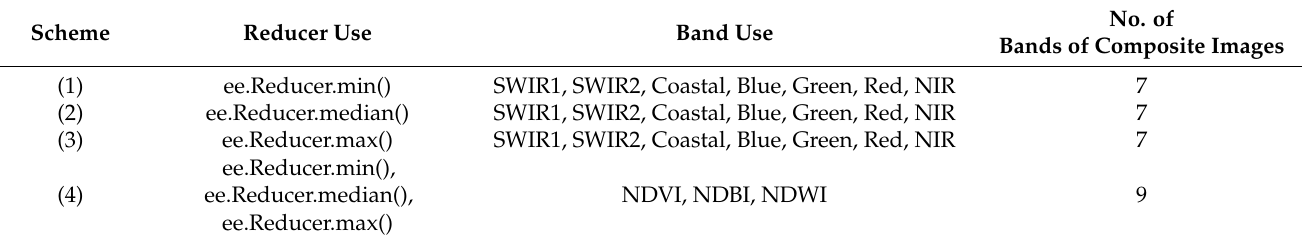
Table 3. The four schemes for image compositing of annual time series data at each study